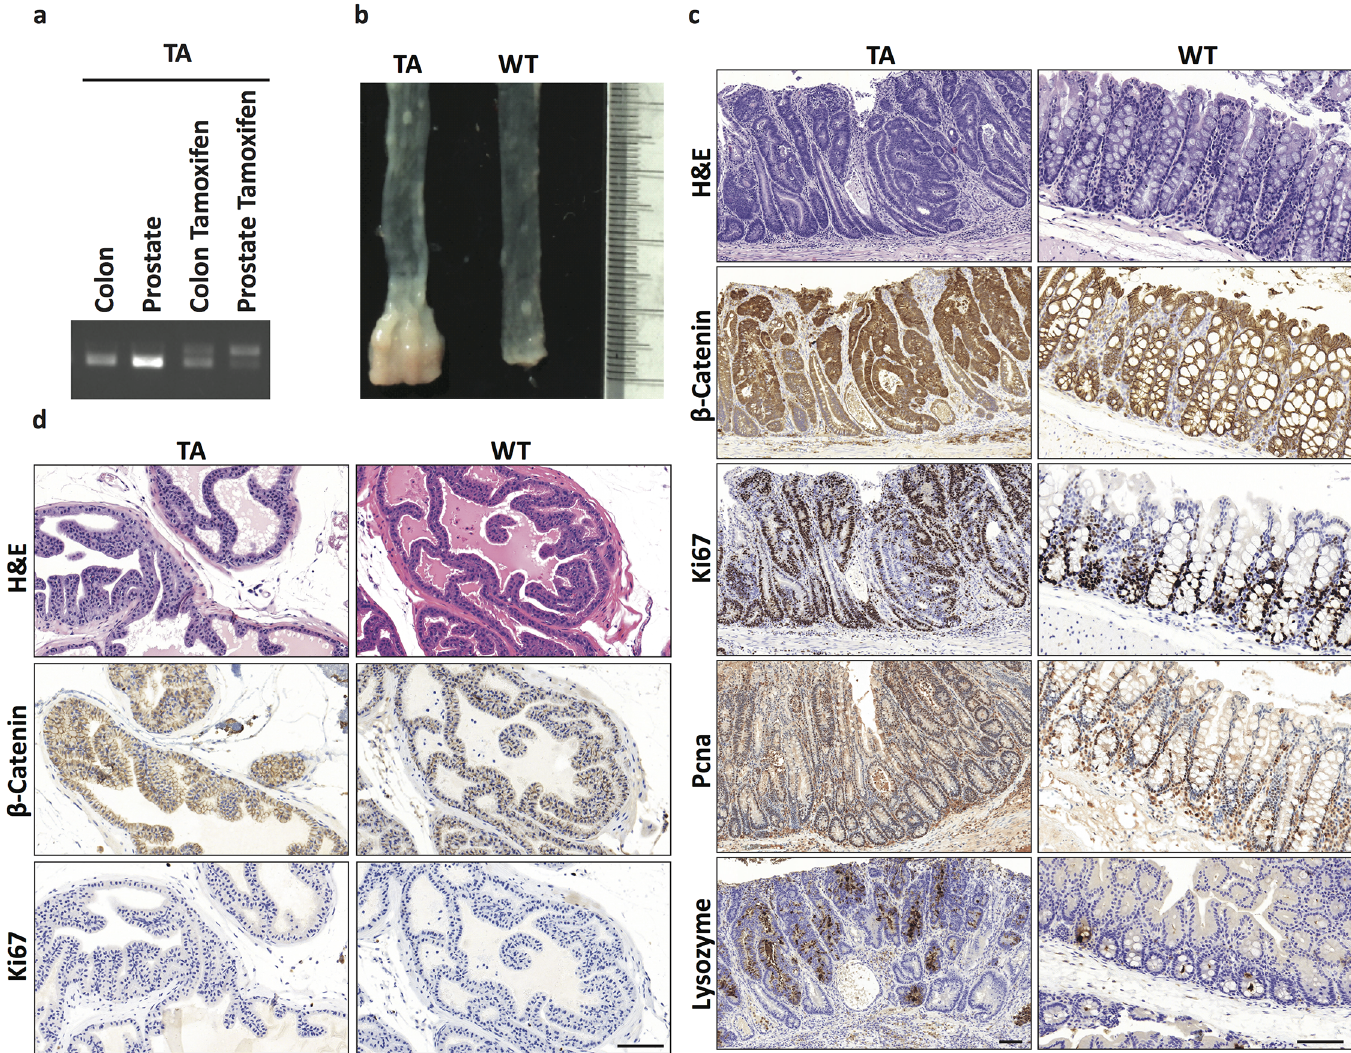
Fig 5. Tissue specific tumorigenesis of Apc deletion. (a) Characterization of Cre-mediated recombination in Tam-treated Tmprss2CreER T2/ T2 ; Apc LoxP/LoxP (TA) mice. Genomic DNA isolated from the indicated organs of a Tam-treated mouse were analyzed by PCR. The positions of the Apc floxed 498bp, and recombined 568bp DNA segments are indicated. (b) Gross pathology of colon of TA and wild-type mice following tamoxifen administration showing macroscopic colon polyps in tamoxifen treated mice. (c) H&E and β -catenin, Ki67 stain of TA and wild-type mouse colon. (d) H&E and β -catenin, Ki67 stain of TA and wild-type mouse prostate. Scale bars represent 100 μ